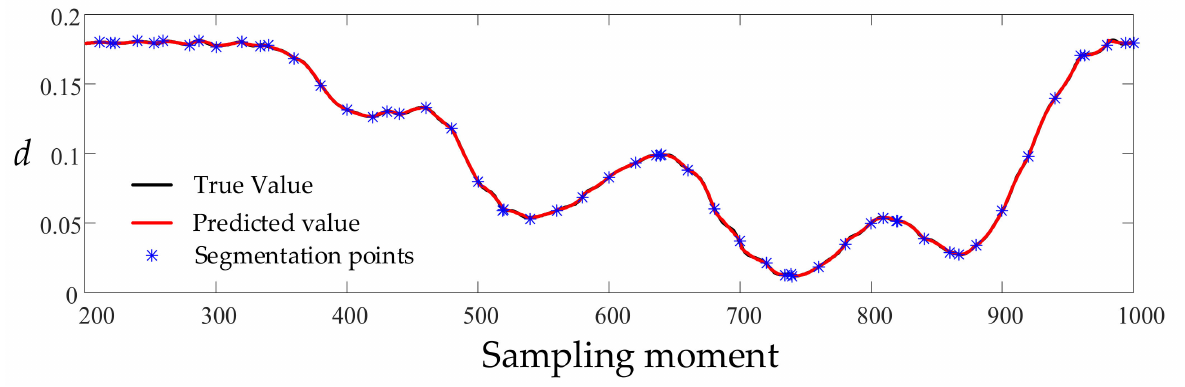
Figure 12. Variation curve of indicator d after